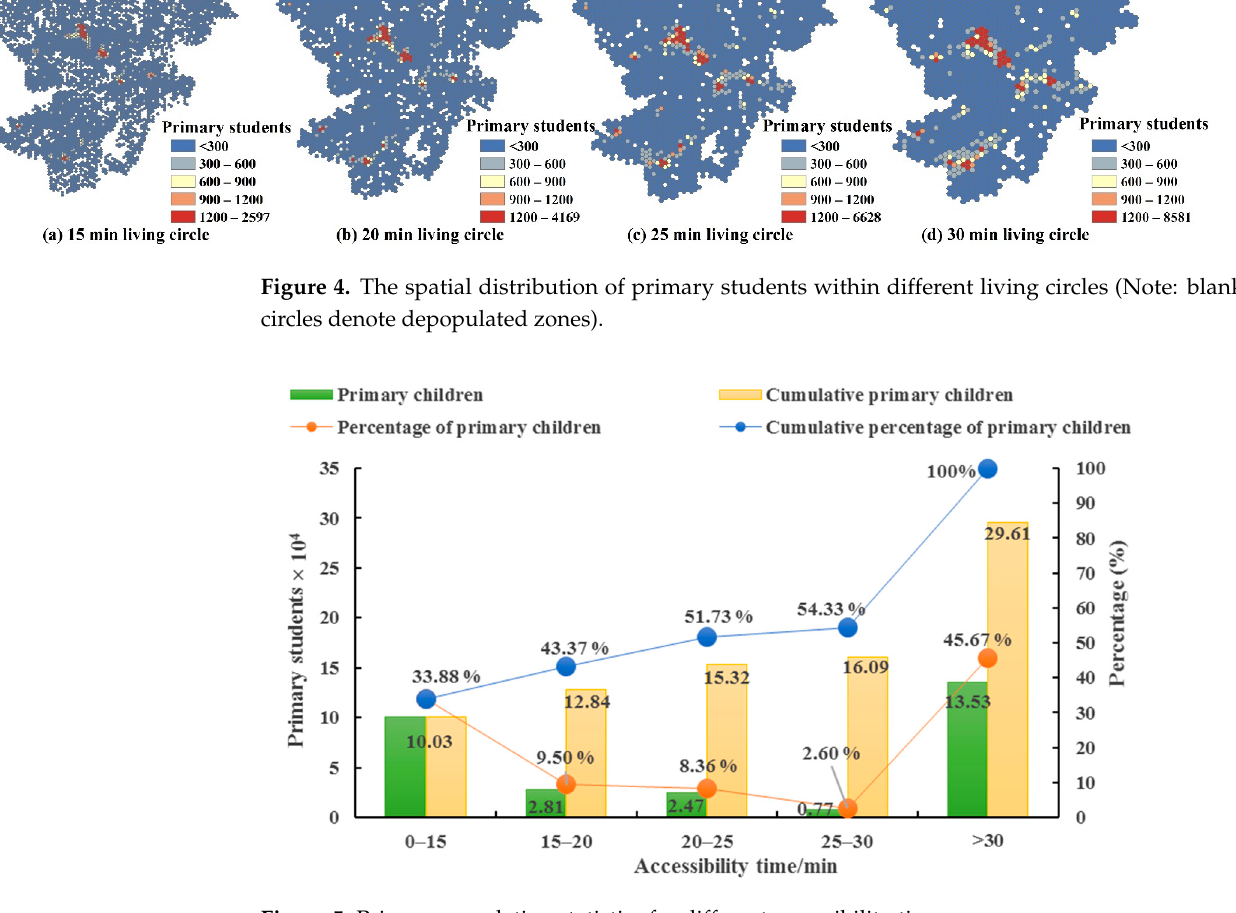
Figure 5. Primary population statistics for different accessibility times.